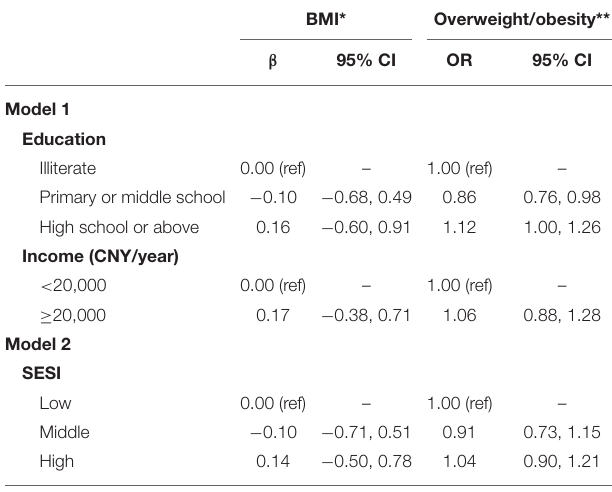
TABLE 2 | Effects of socioeconomic status on BMI and overweight/obesity by multiple regression